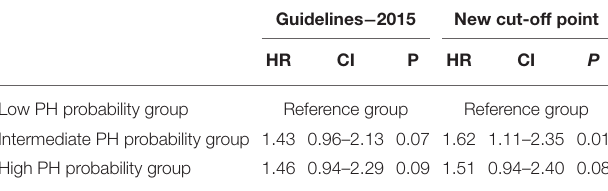
TABLE 4 | Relative risk of all-cause mortality on multivariate analysis according to ESC/ERS and the new cut-off point thresholds, in all